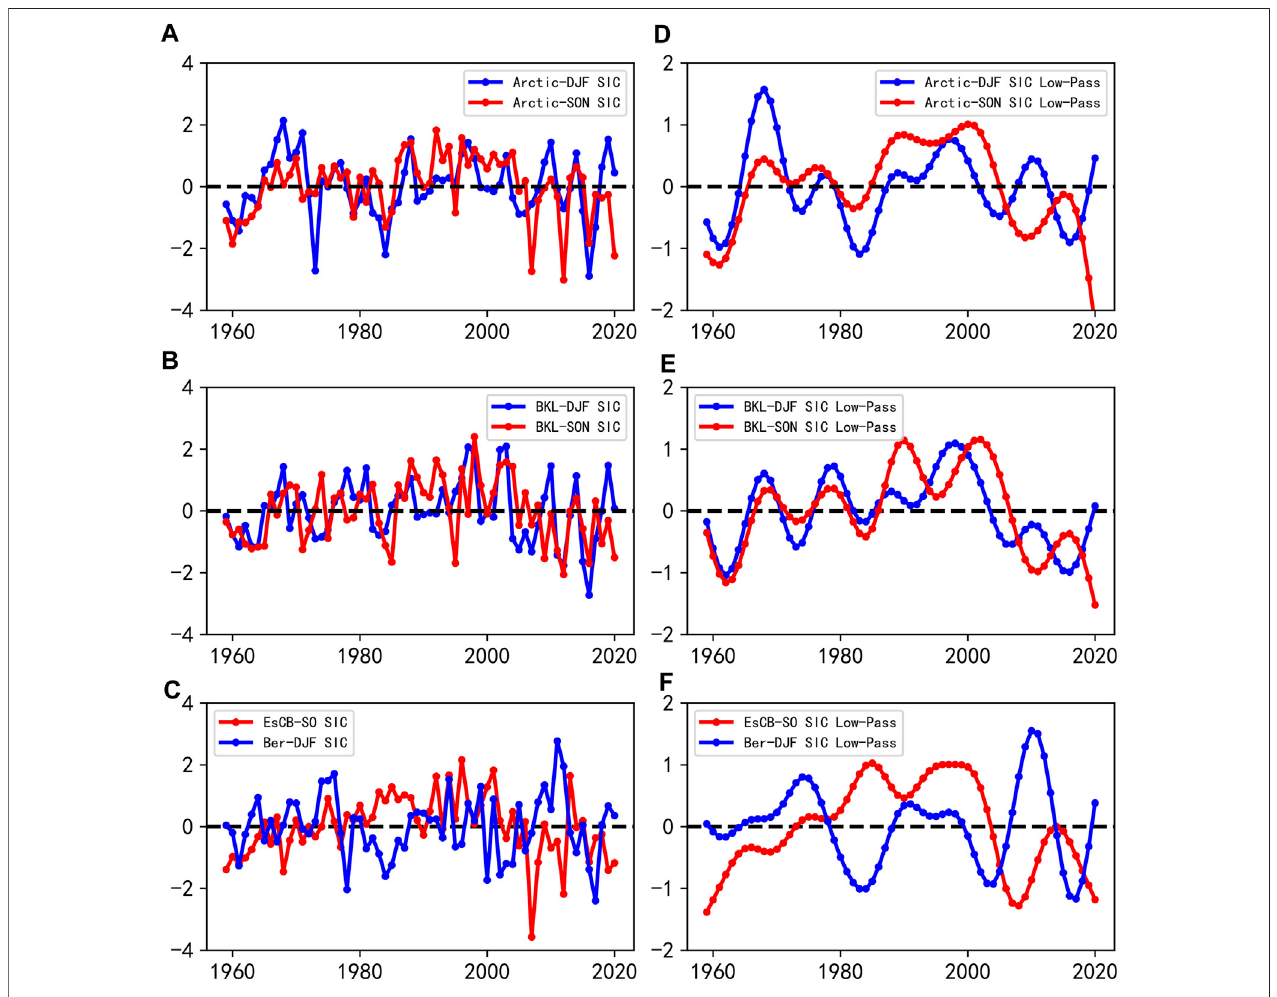
FIGURE 10 | As in Figure 1 but for the period from 1959 to